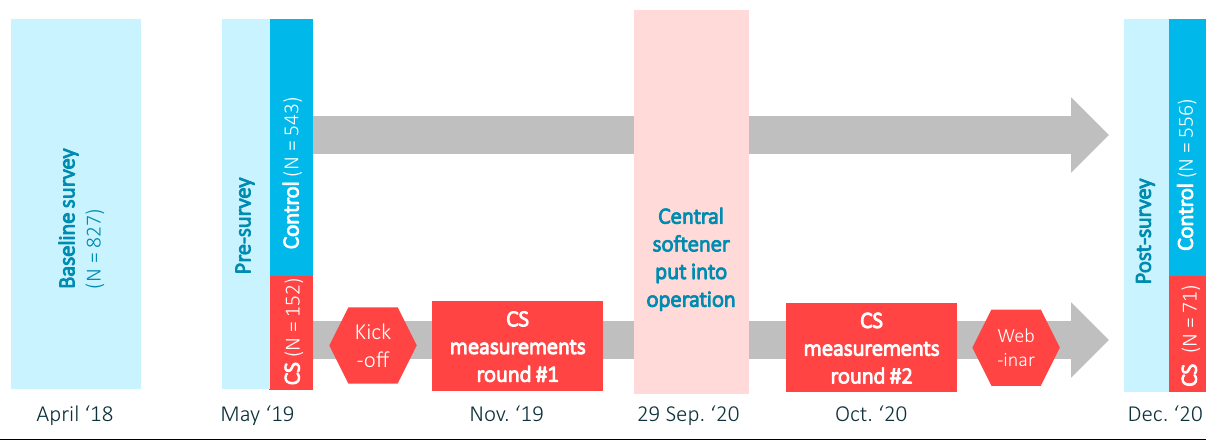
Figure 1 Study design and timeline of activities. All steps followed by the citizen science participants are marked in red. CS: citizen science.